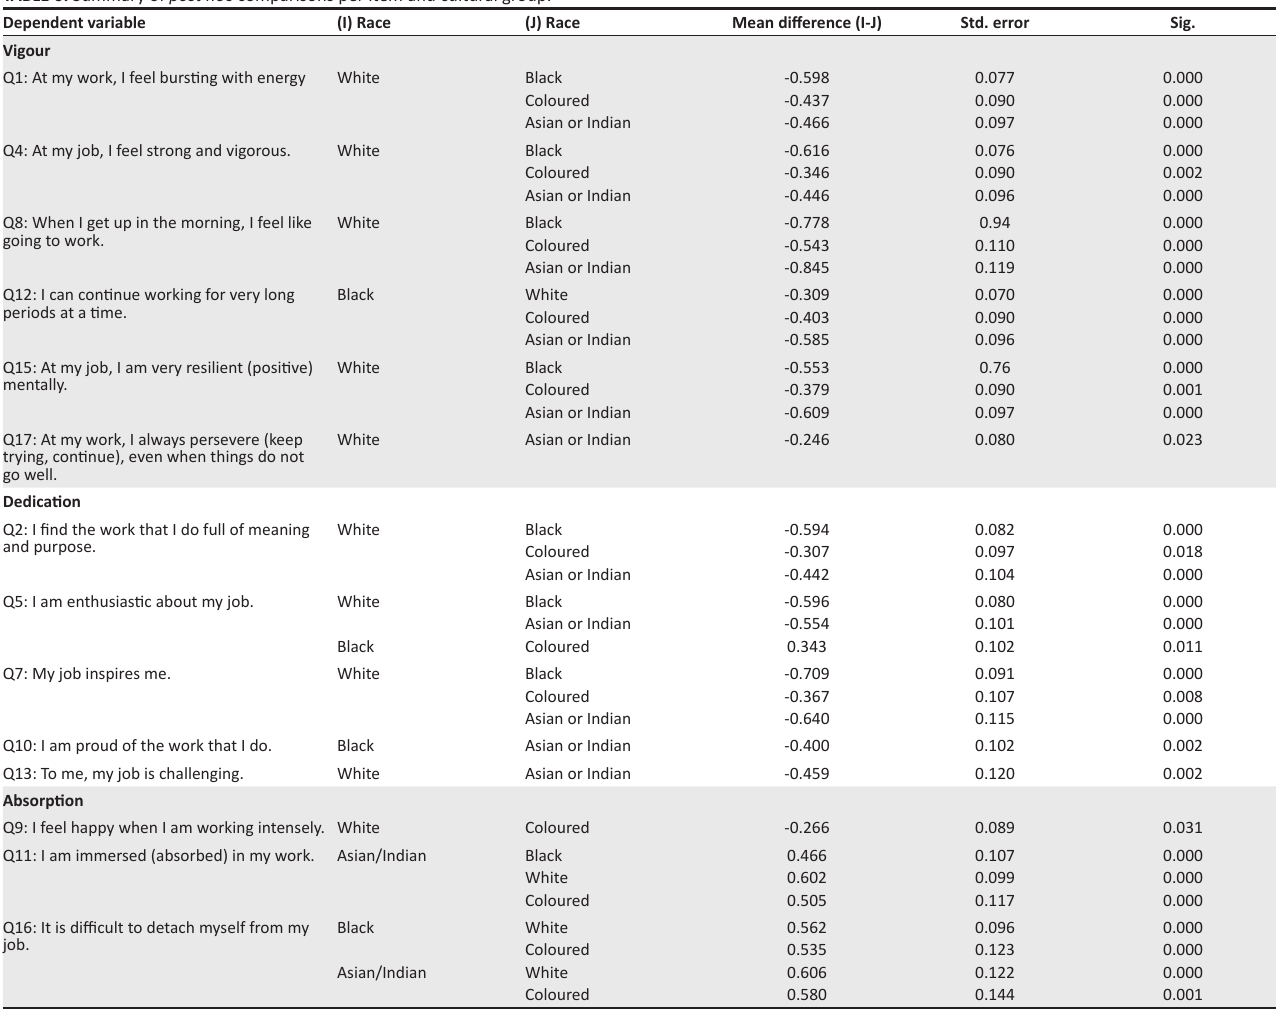
TABLE 6: Summary of post hoc comparisons per item and cultural group. Dependent variable